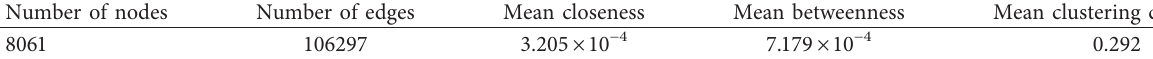
Table 1: The information of the sharing-bike